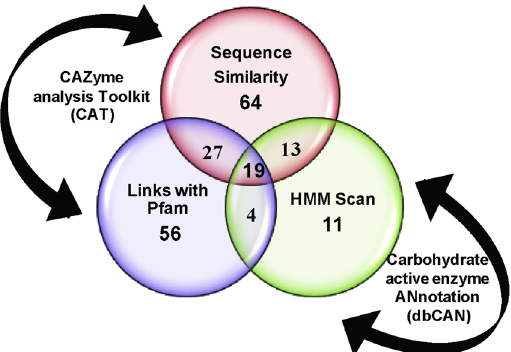
Figure 1. Venn diagram representing the number of CBMs predicted by different approaches in the genome of P . polymyxa A18. Detailed analysis is provided in Supplementary Table